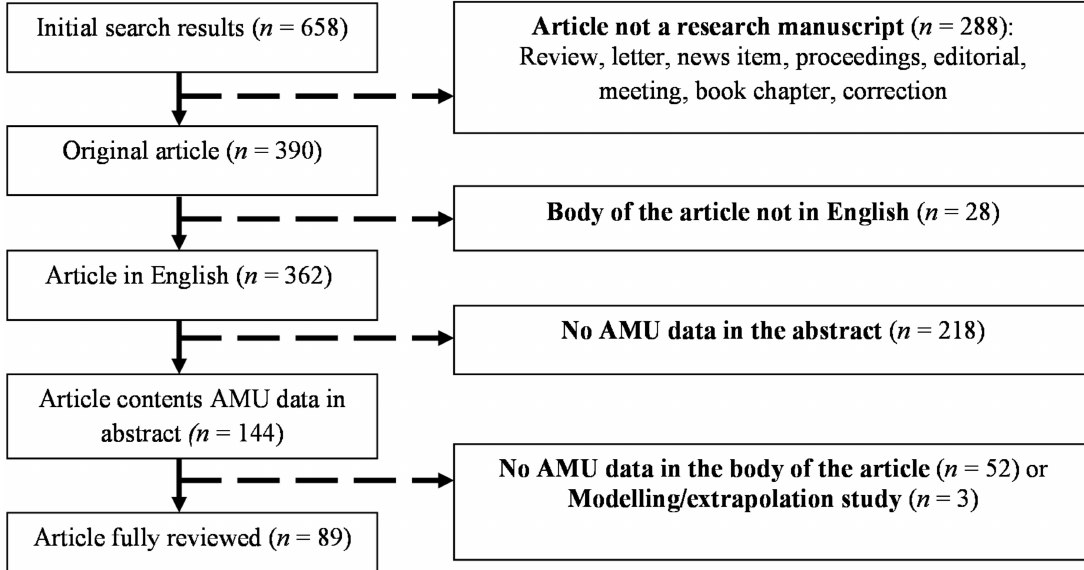
Figure 1. Selection and exclusion criteria for scientific publications on antimicrobial use (AMU) in animal